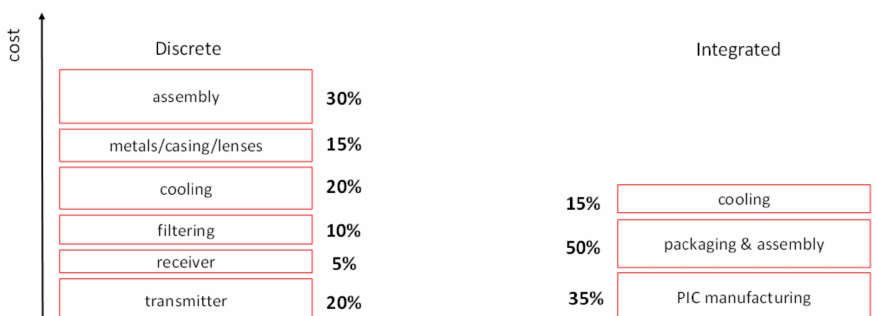
Figure 4. Cost structure comparison of a discrete and integrated implementation of a PIC-based tunable